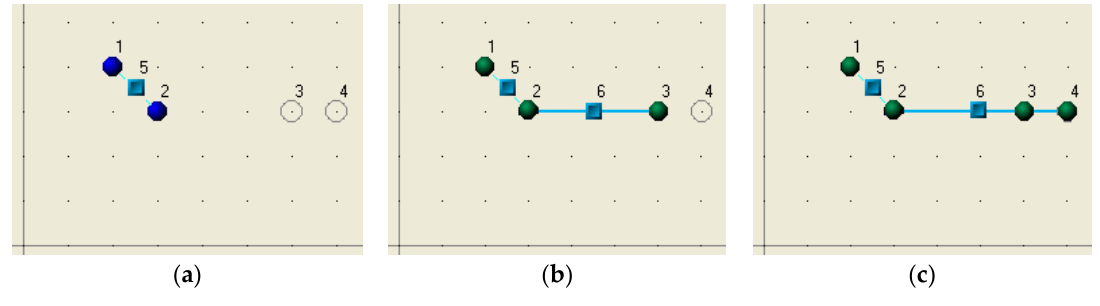
Figure 4. ( a ) Formation of line Cluster 5; ( b ) Formation of Cluster 6; ( c ) New Cluster 6